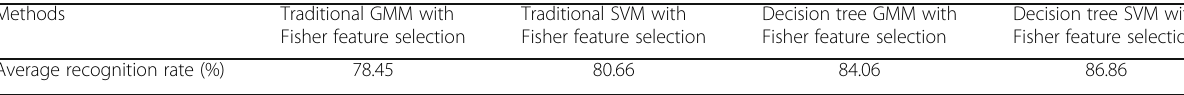
Table 10 Average recognition rate of different classifiers on EMO-DB (%) Methods Traditional GMM with Traditional SVM with Fisher feature selection Fisher feature selection